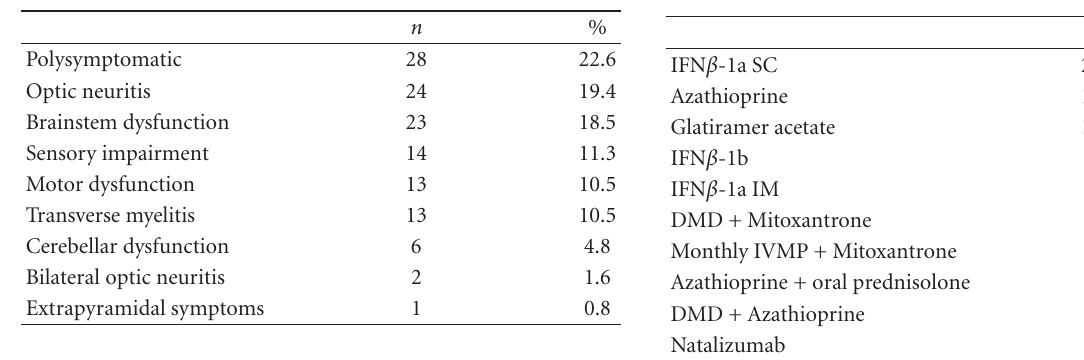
Table 2: Onset of disease. Table 3: Disease-modifying drugs and immunosuppressant